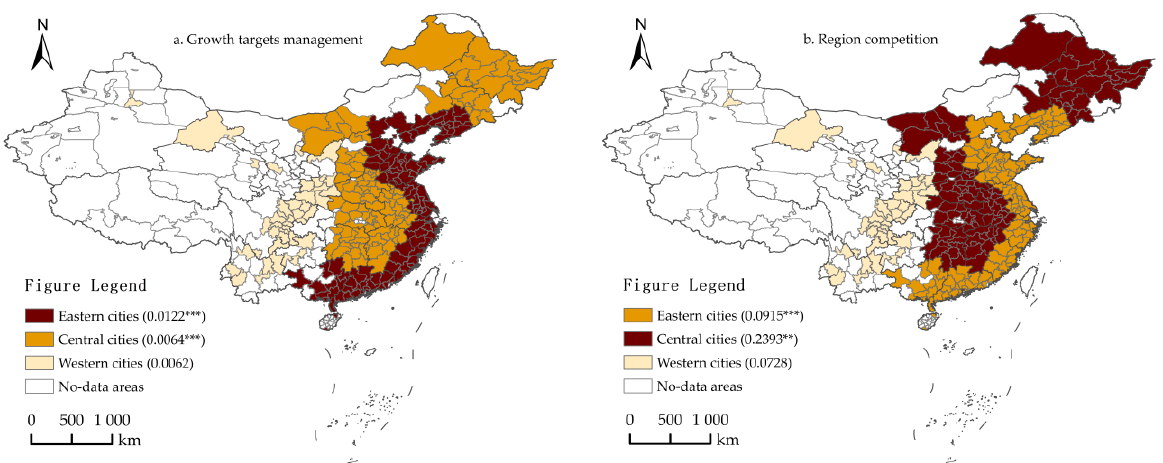
Figure 4. Heterogeneity analysis results (Regions). ( a ) The impact of growth targets management (gt) on ULUGE; ( b ) the impact of regional competition (w · gt) on ULUGE. *** and ** denote significance at the 0.01 and 0.05 levels, respectively. Except for the no-data area, the shade of the color represents the relative strength of the effect. The darker the color, the greater the relative strength of its effect. Table 10. Heterogeneity analysis results (Regions).